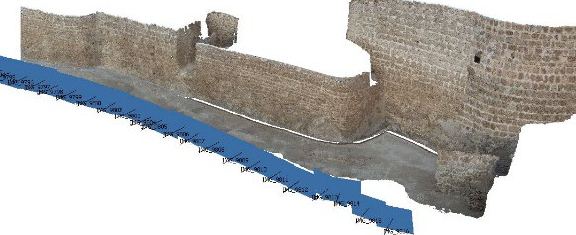
Figure 6. Close-range photogrammetric point cloud model, interior wall of Qal'at al-Bahrain.